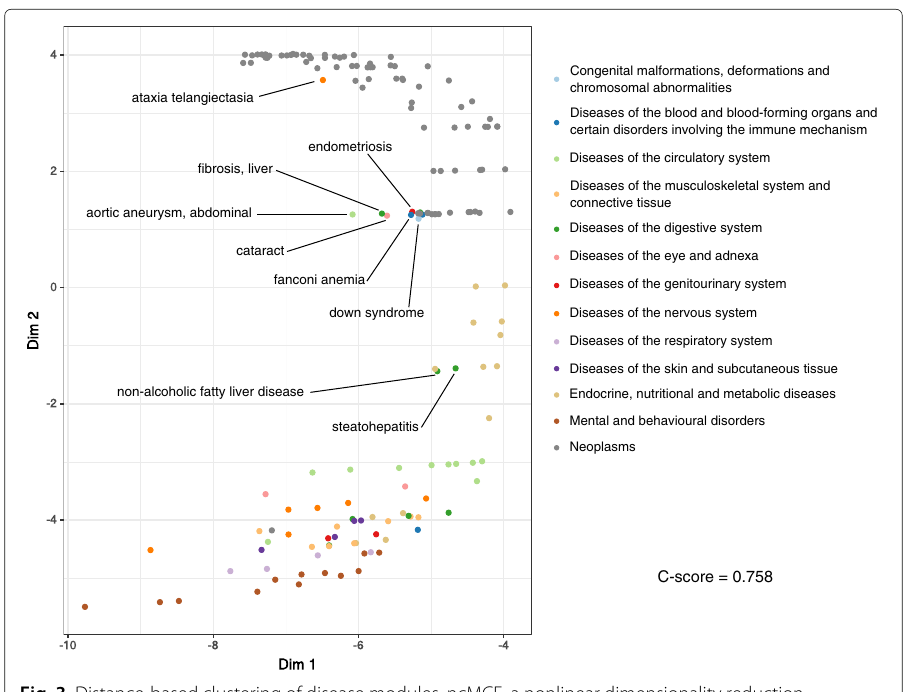
Fig. 3 Distance-based clustering of disease modules. ncMCE, a nonlinear dimensionality reduction algorithm, was applied to the matrix of pairwise hyperbolic distance-based DM separations. The resulting two-dimensional projection of the data separates DMs according to the disease type reported in the ICD-10. Some interesting DMs that were not correctly clustered are highlighted. The concordance score (C-score) over Dim 2 for this projection is 0.758. The points corresponding to endometriosis and downsyndrome were slightly moved to make them